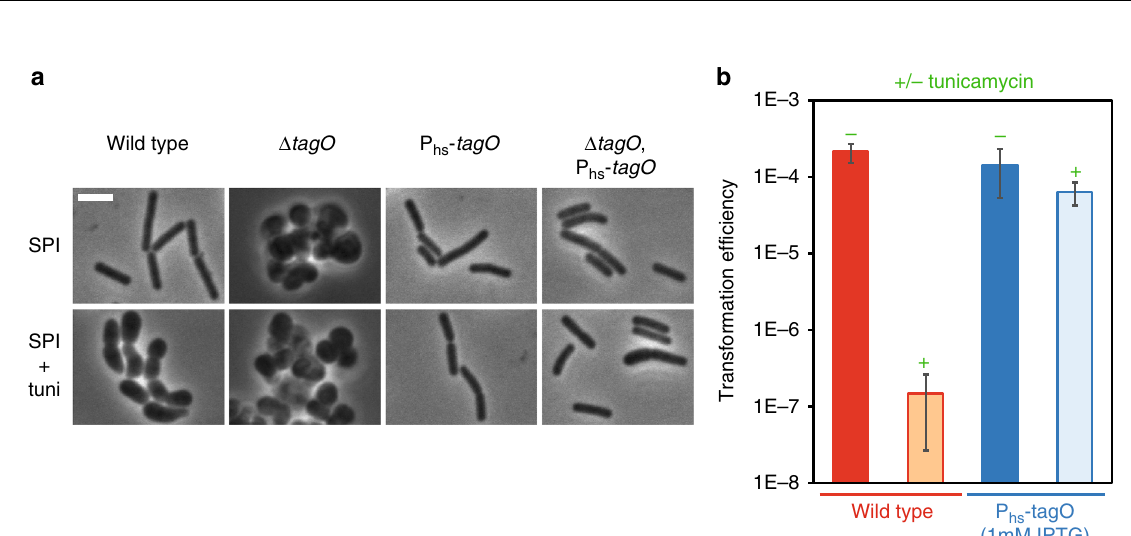
The different B. subtilis strains studied were transformed (1 or 2-steps protocol, as indicated), in the presence (0.31 µ g/ml) or in the absence of tunicamycin, using chromosomal DNA carrying a tetracycline marker. Each data point was repeated at least 3 times. The last columns show the ratio and fold-difference between each data point and the wild-type reference